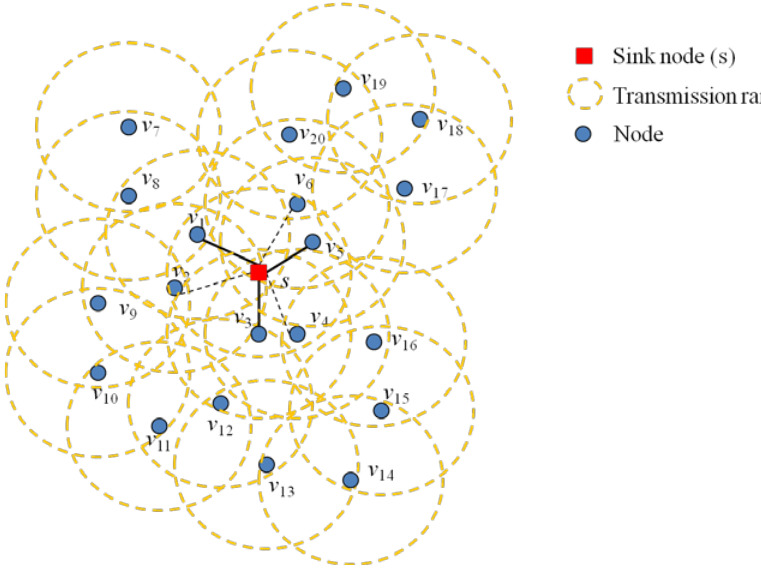
, v and v , respectively, are 1 3 6